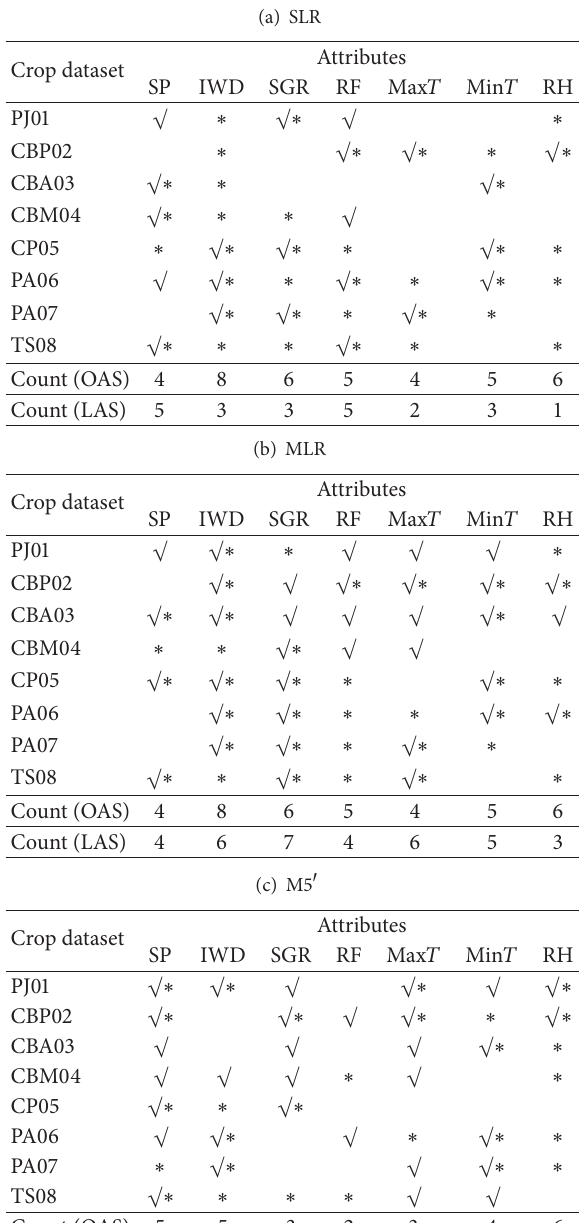
Table4:AttributesinOASandLASselectedbyeachcroptechnique. Attributes in optimal subset (OAS) are remarked with asterisks. Attributes selected with training data (LAS) are identified with the √ symbol.